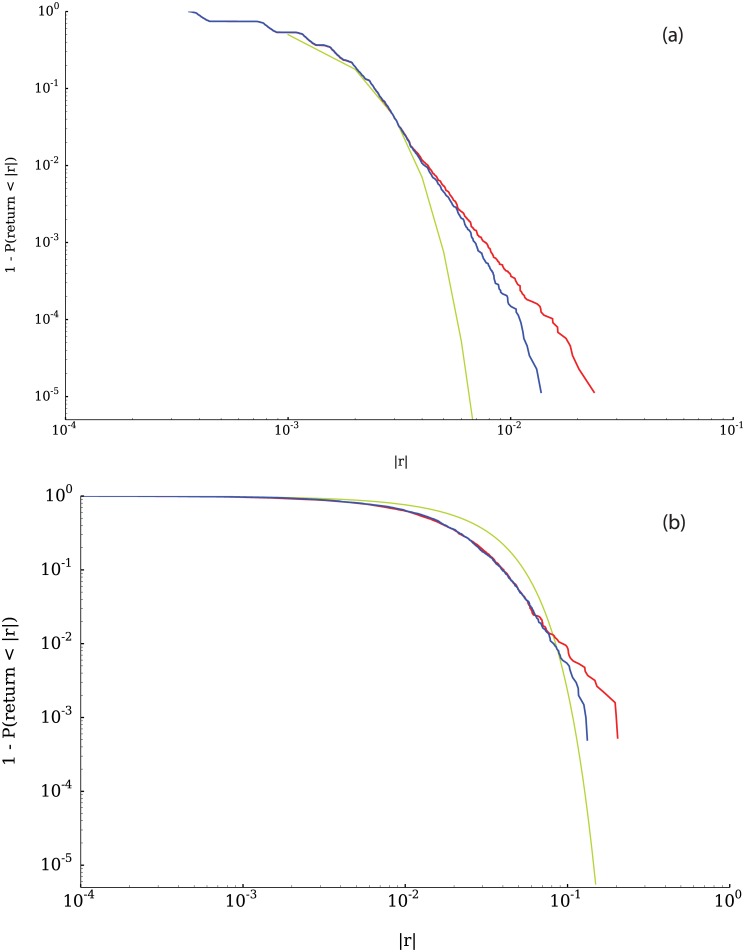
Comparison of the positive and negative returns CDF from the simulation (a) and from empirical data for Anadarko Petroleum Corp (b).It can be seen that the left tail of the distribution (red line), corresponding to the negative returns, is heavier than the right tail (blue line), corresponding to the positive returns. This is related to the negative skewness observed in the distribution.